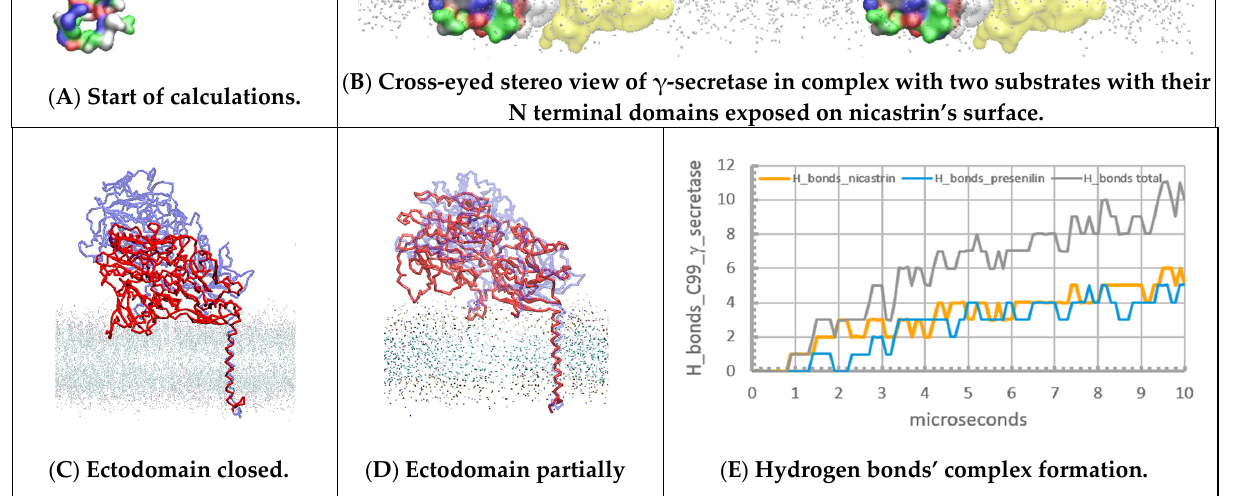
( E ) Hydrogen bonds’ complex formation.